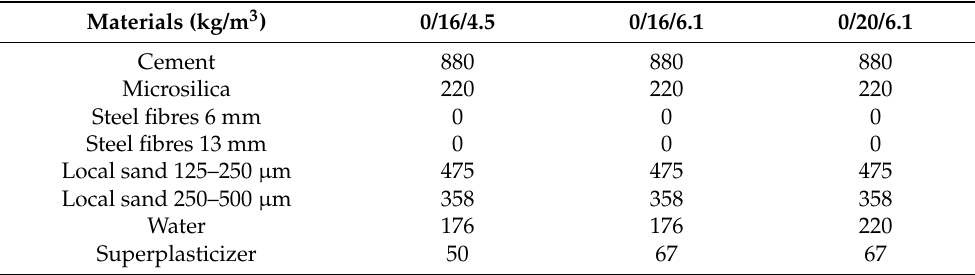
Table 1. Mixture designs for UHPC.